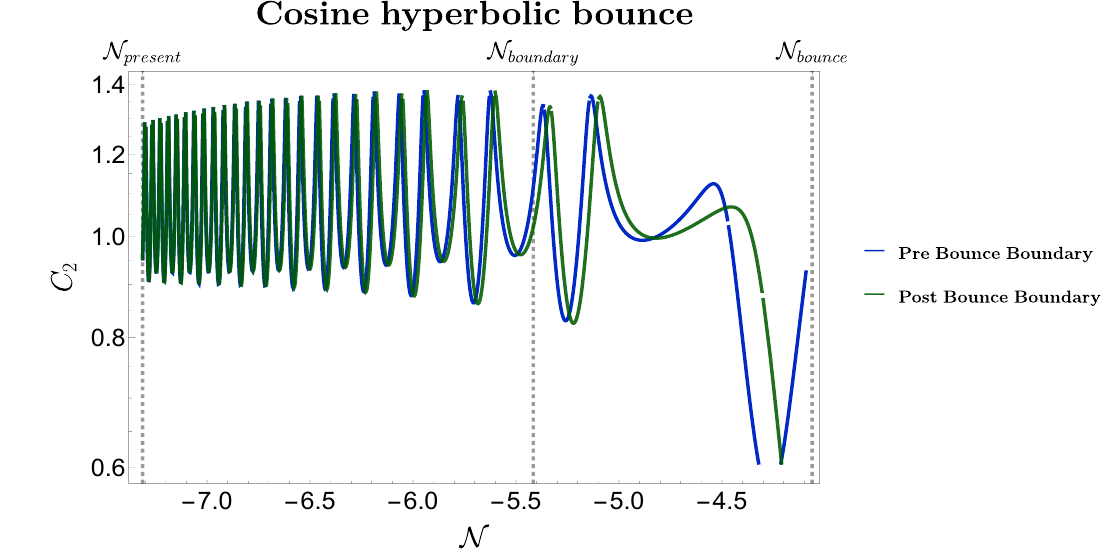
Figure 21: Variation of geodesically weighted complexity outside bouncing region with respect to number of